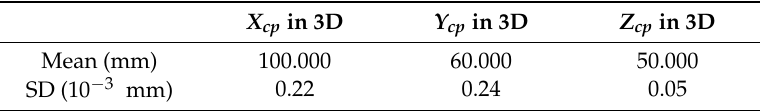
Figure 10. Simulated plane and cylinder touched by the TP. Table 2. Intersection point and